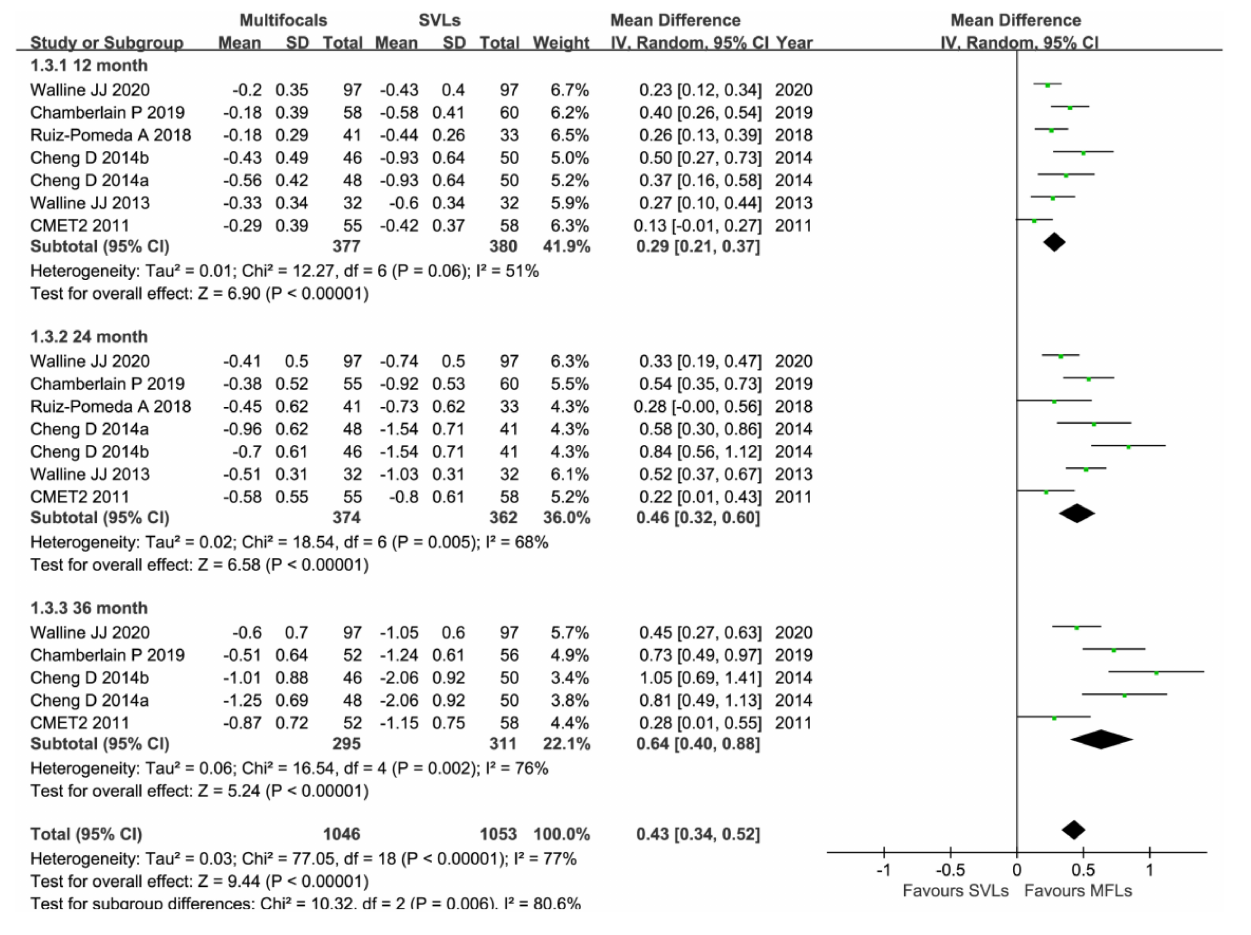
FIGURE 3 | Forest plot about the change of SER in annual interval visit